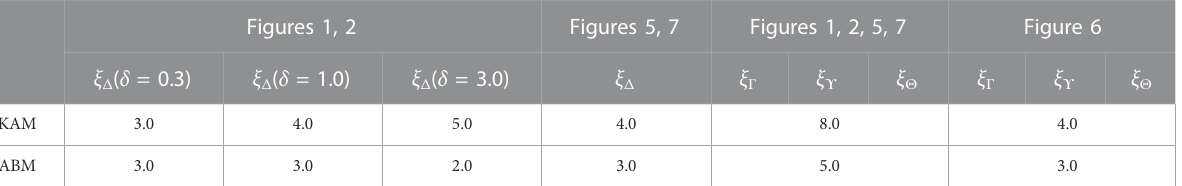
TABLE 3 Coarse-graining length for each